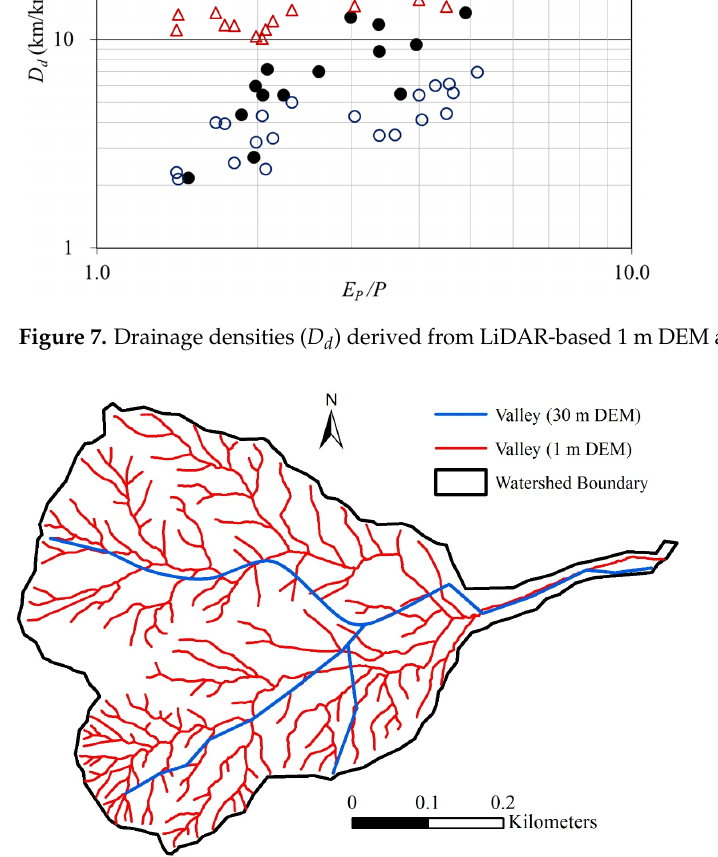
Figure 8. The derived valley lines from 1 m DEM and 30 m DEM in the Isleta Drain watershed located in New Mexico.